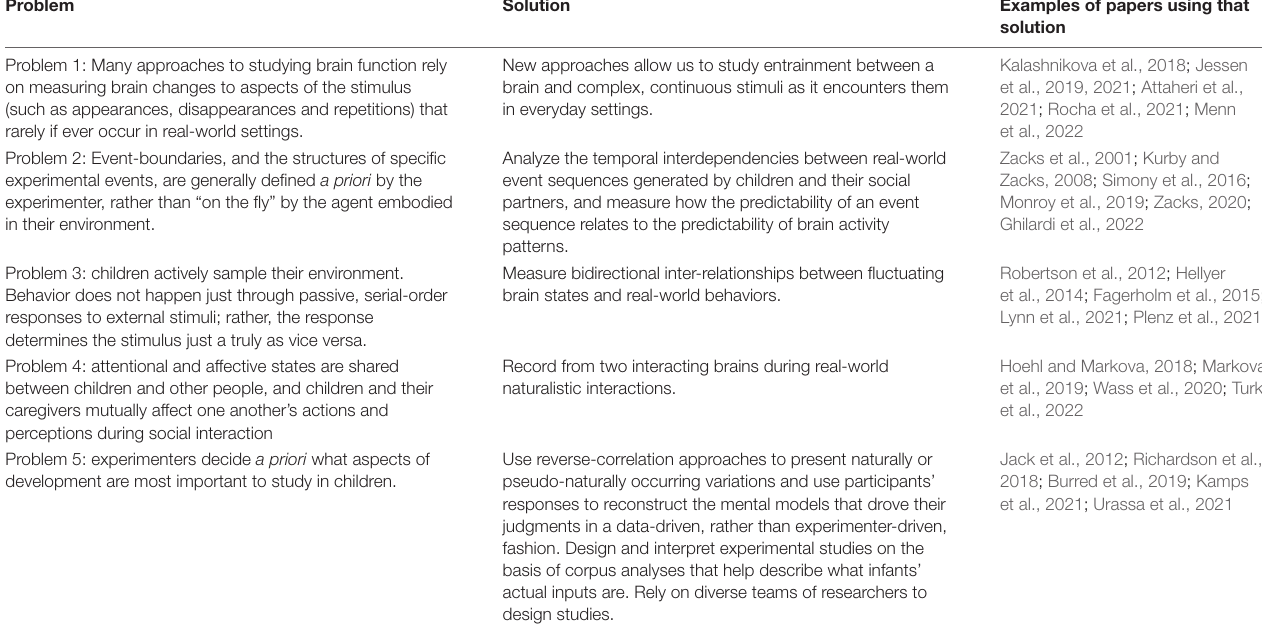
TABLE 1 | A summary of the main problems, and solutions, discussed in this paper. Problem